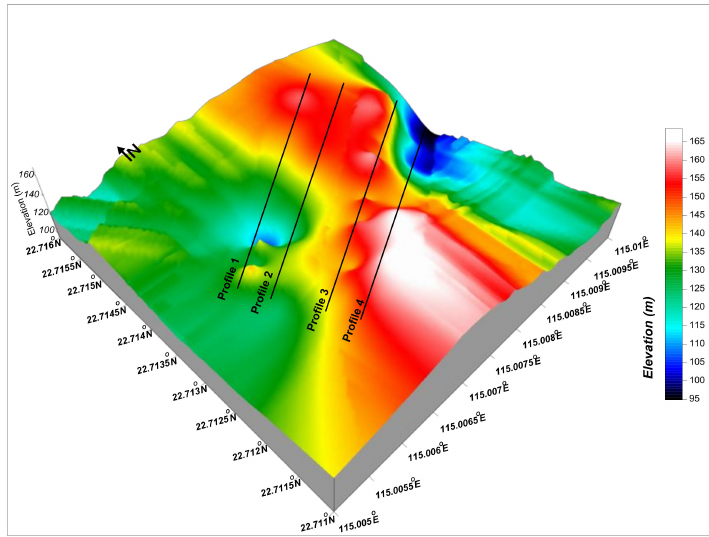
Figure 3. Topography map of the study